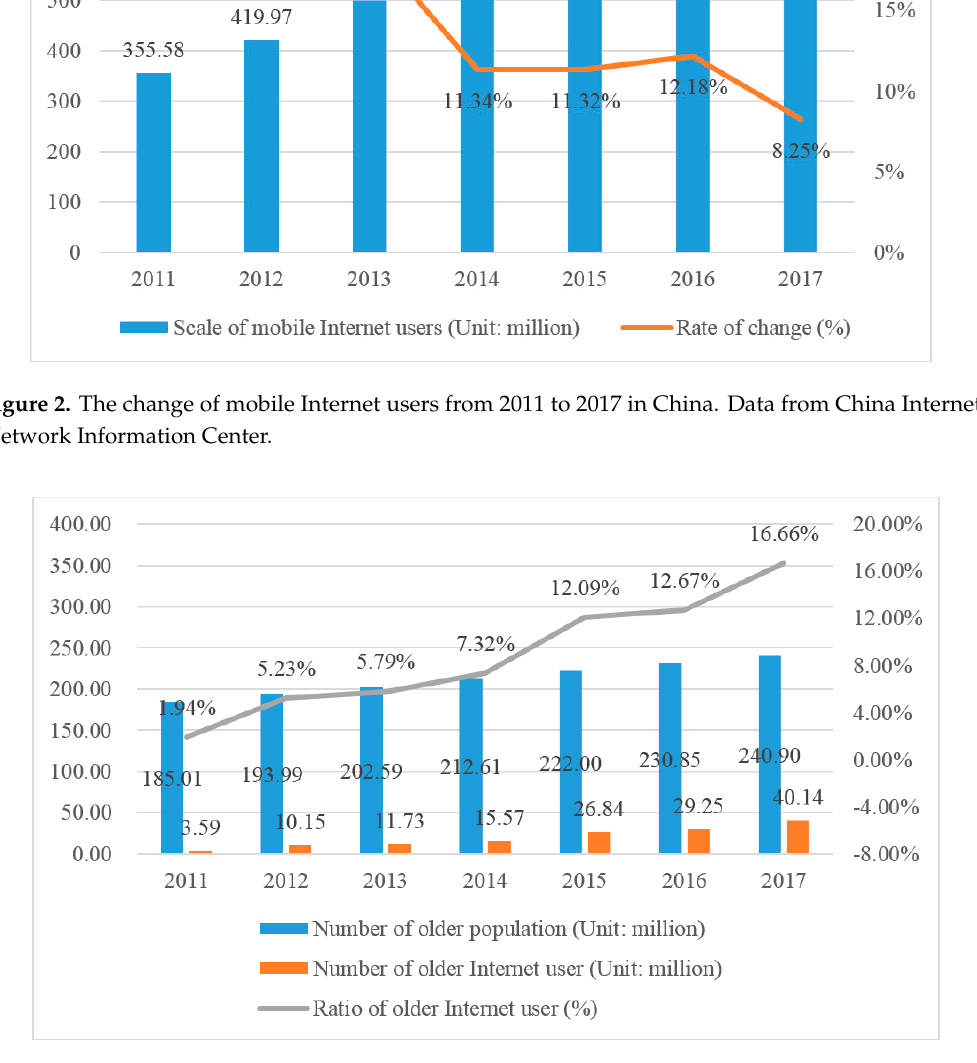
Figure 3. The popularity rate of Internet in Chinese older population from 2011 to 2017. Data from China Bureau of Statistics and Internet Network Information Center.